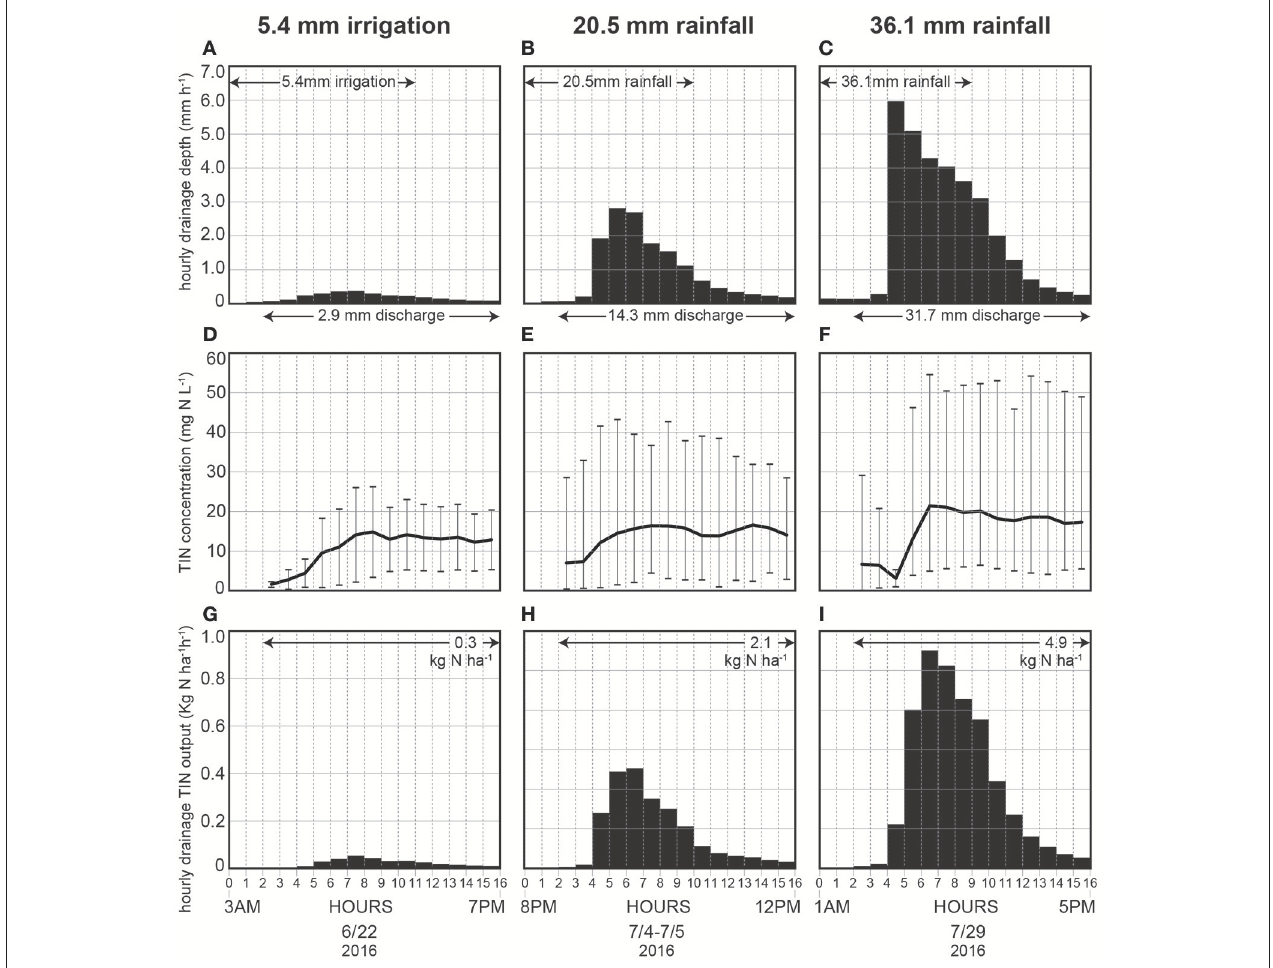
FIGURE 6 | Hourly drainage depth (A–C) , TIN concentration (D–F) , and drainage TIN output (G–I) during the brief monitoring campaigns on 6/22, 7/4-5, 7/29 in